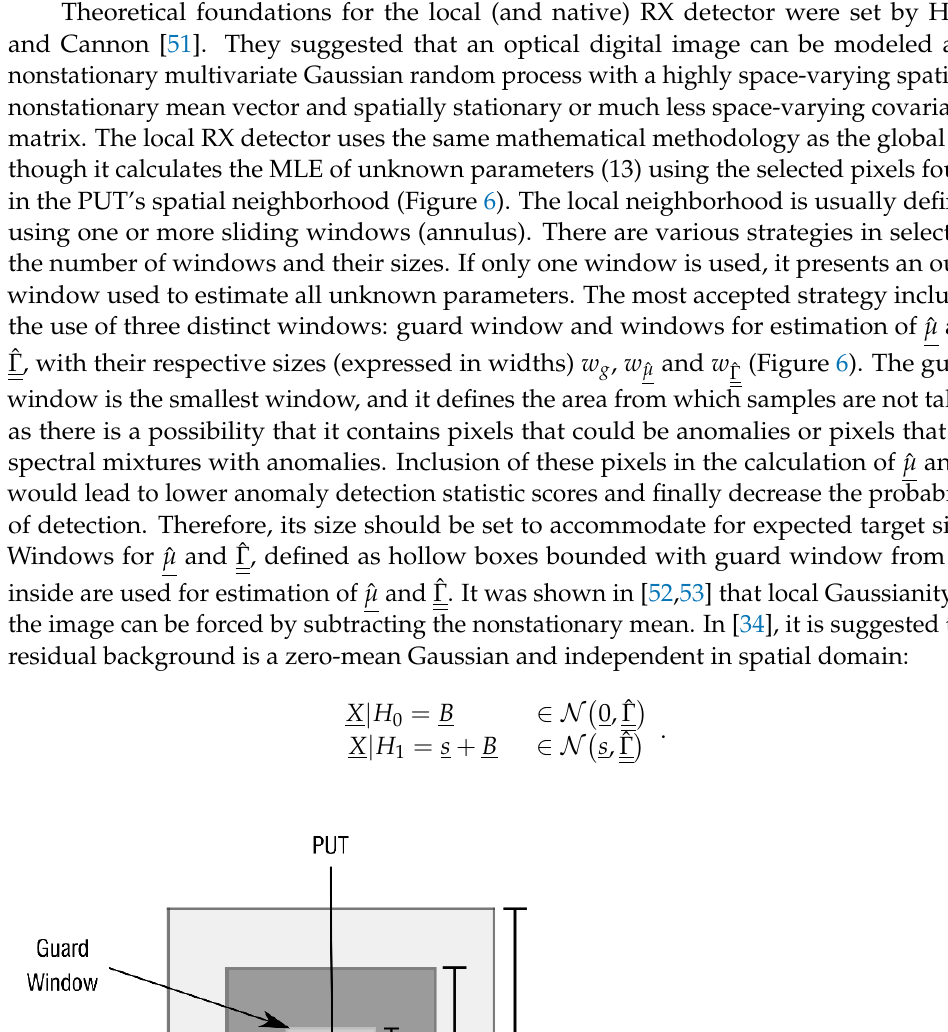
and , with their respective widths , and . 𝛤𝛤� 𝜇𝜇̂ 𝑤𝑤 𝑔𝑔 𝑤𝑤 𝜇𝜇� 𝑤𝑤 𝛤𝛤�